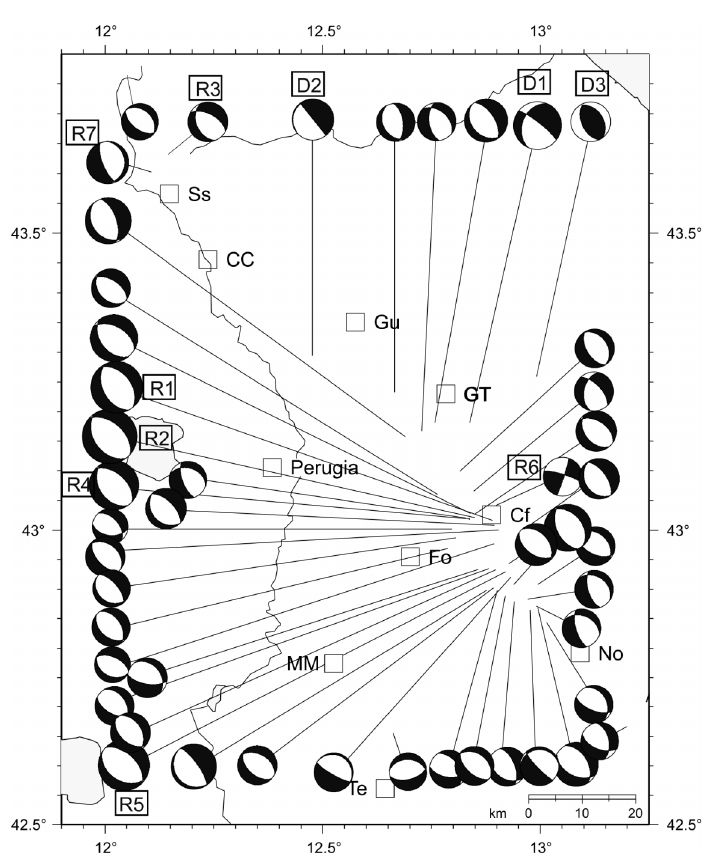
Fig. 4. Map of moment tensors available for the study region from the European-Mediterranean RCMT Cata- log (1997-2000).